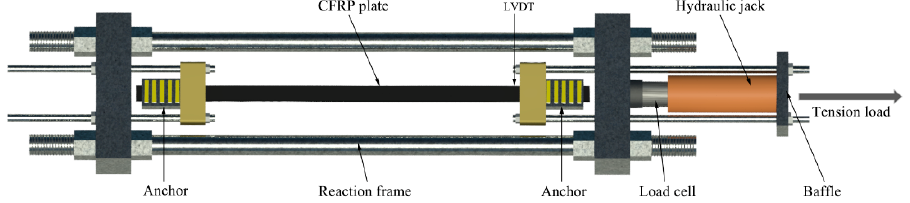
Figure 10. Schematic diagram of testing apparatus.